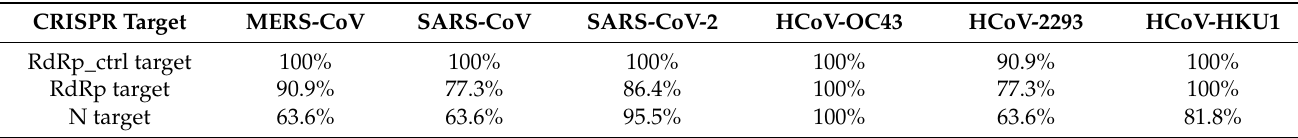
Table 5. Percent identity of CRISPR targets with HCoV species.